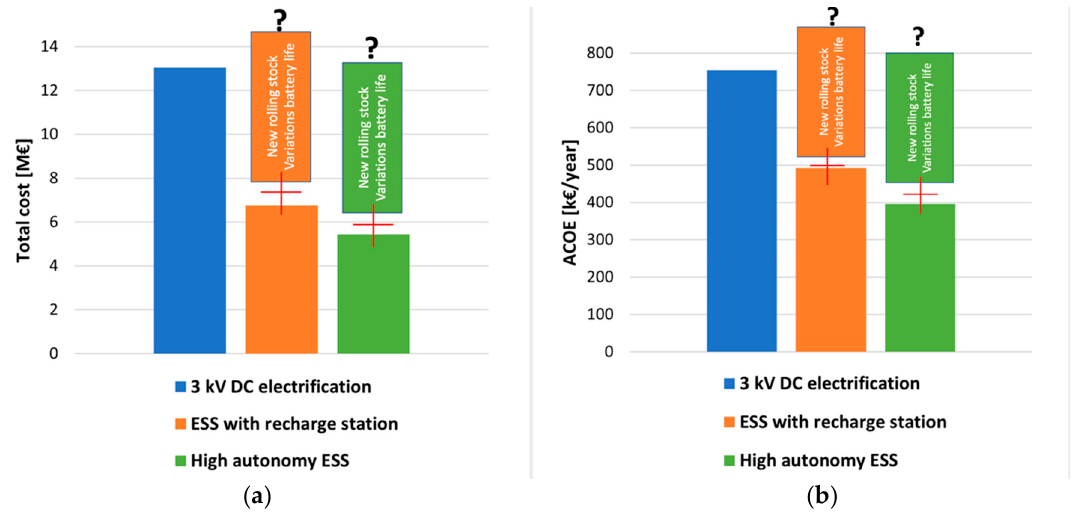
Figure 21. Di ff erent scenarios comparison: ( a ) Present value of total cost; ( b ) Figure 21. Different scenarios comparison: ( a ) Present value of total cost; ( b ) ACOE.